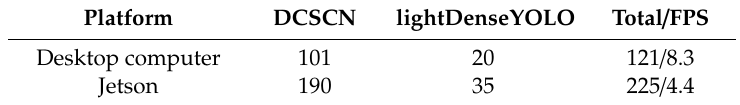
Table 18. Total processing time (ms) per image by the previous method [21] on two